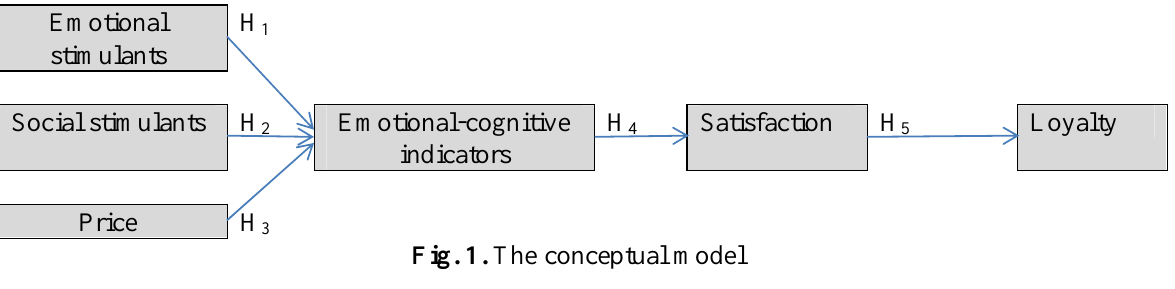
Fig. 1. The conceptual